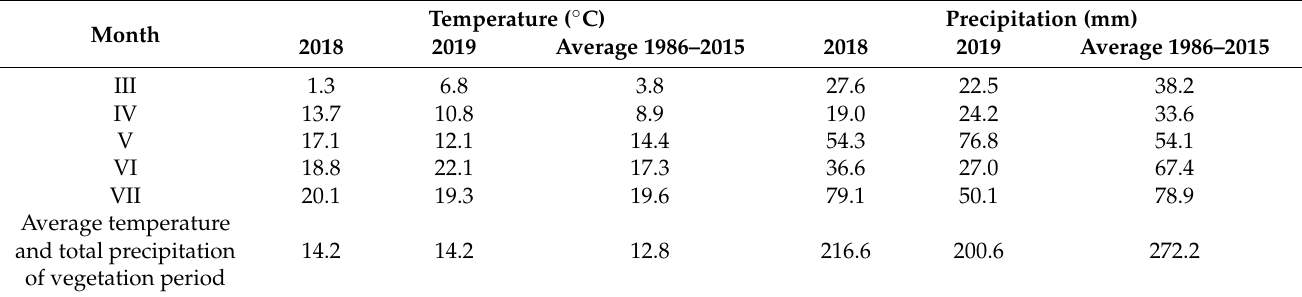
Table 2. Weather conditions in the years of field